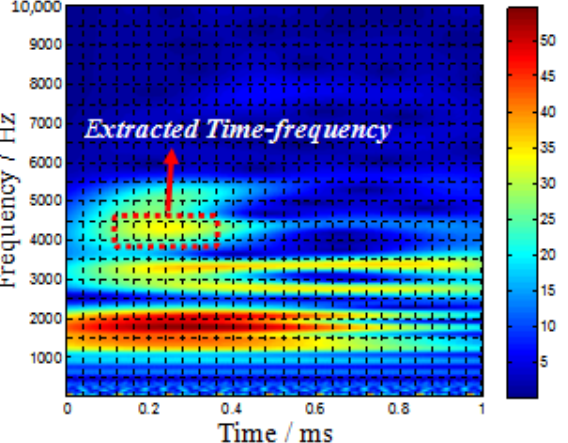
Figure 7. Continuous wavelet transform analysis when impact happens at No. 3 position.